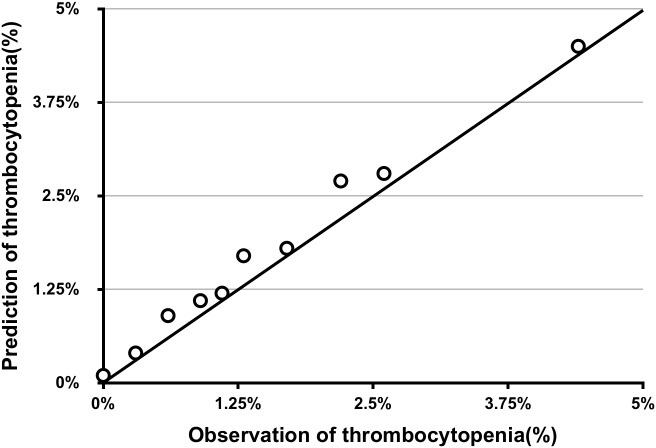
Calibration plot of predicted vs. observed thrombocytopenia of risk score in the validation series.